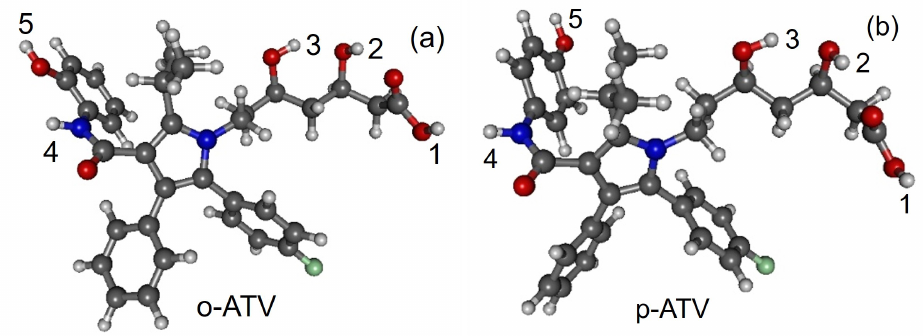
Figure 2. Optimized geometries of atorvastatin ortho- and para-hydroxy metabolites: ( a ) o-ATV and ( b ) p-ATV. Figure generated using GABEDIT [27].